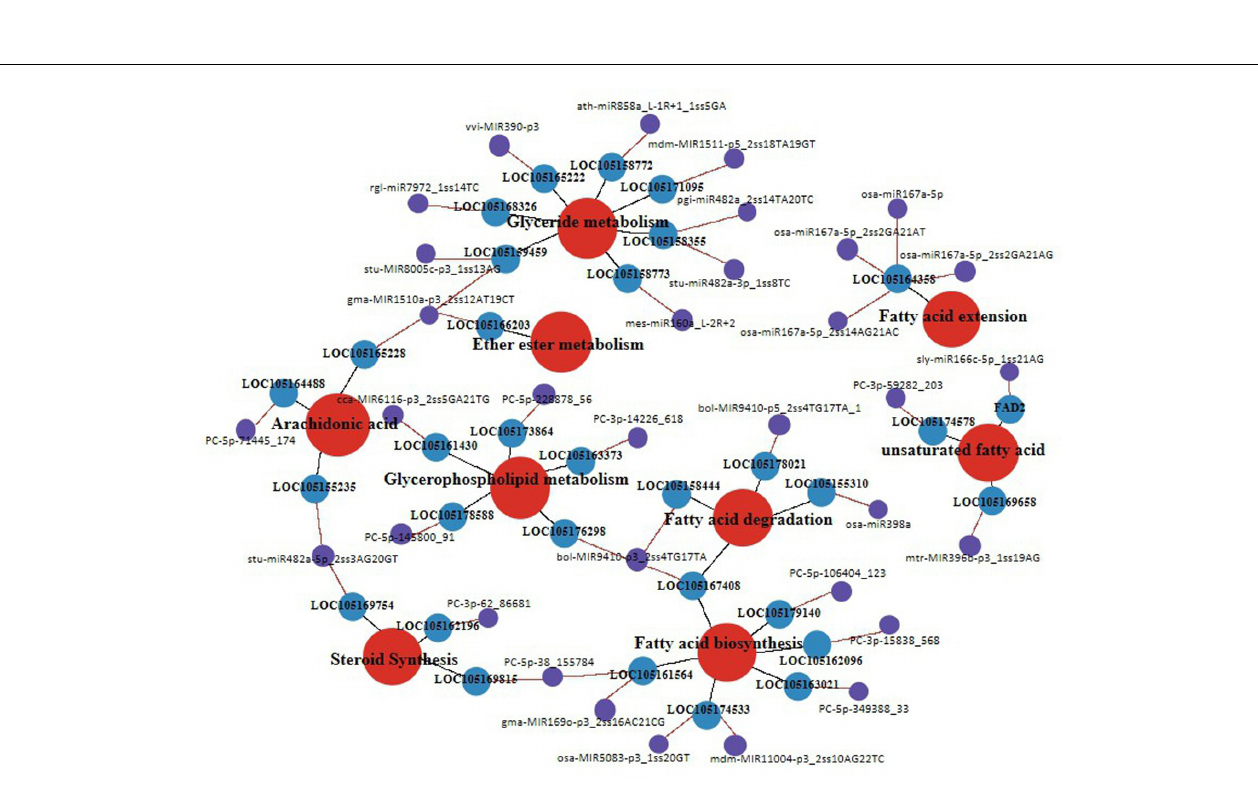
FIGURE 8 | Schemata of lipid synthesis enzymes and genes that related to fatty acid metabolism pathway in the different development periods of sesame seeds. The red color circles show different lipid biosynthesis pathways, blue colors show different expression genes, and purple color shows different expression miRNAs.